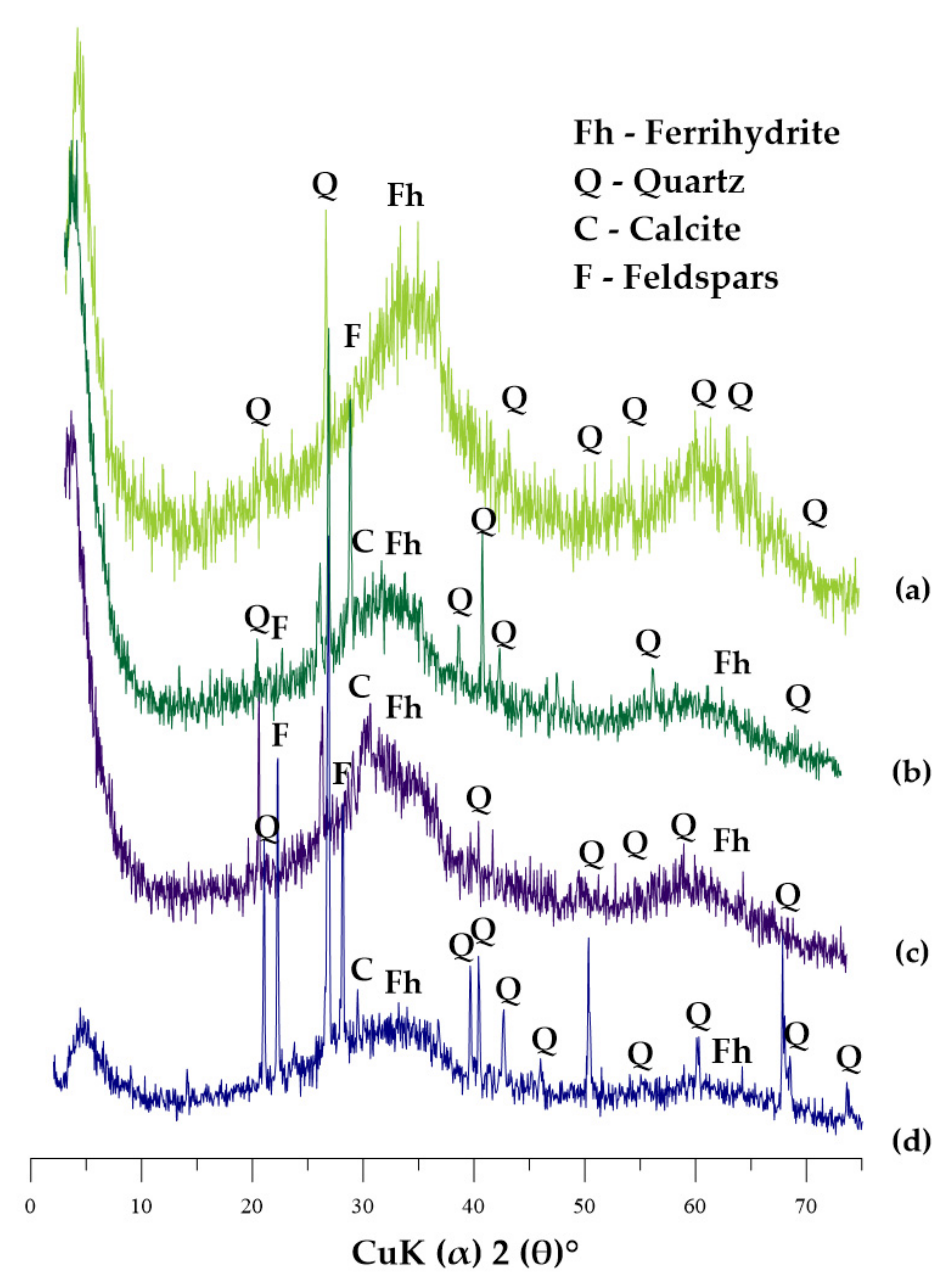
Figure 1. X-ray diffraction patterns of GWTRs. ( a ) GWTRa-1, ( b ) GWTRs-2, ( c ) GWTRs-3, and ( d ) GWTRs-4.